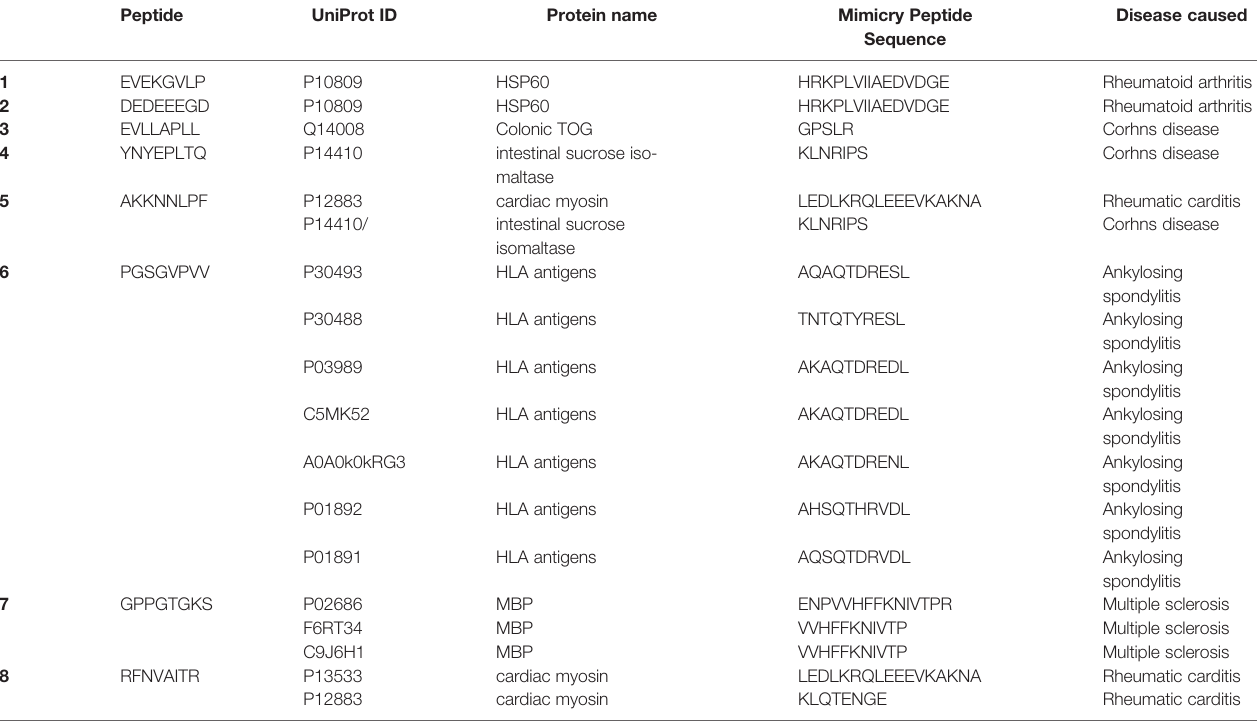
TABLE 3 | The results of the miPepBase. All of the peptides with matching human proteins are analyzed. Peptide